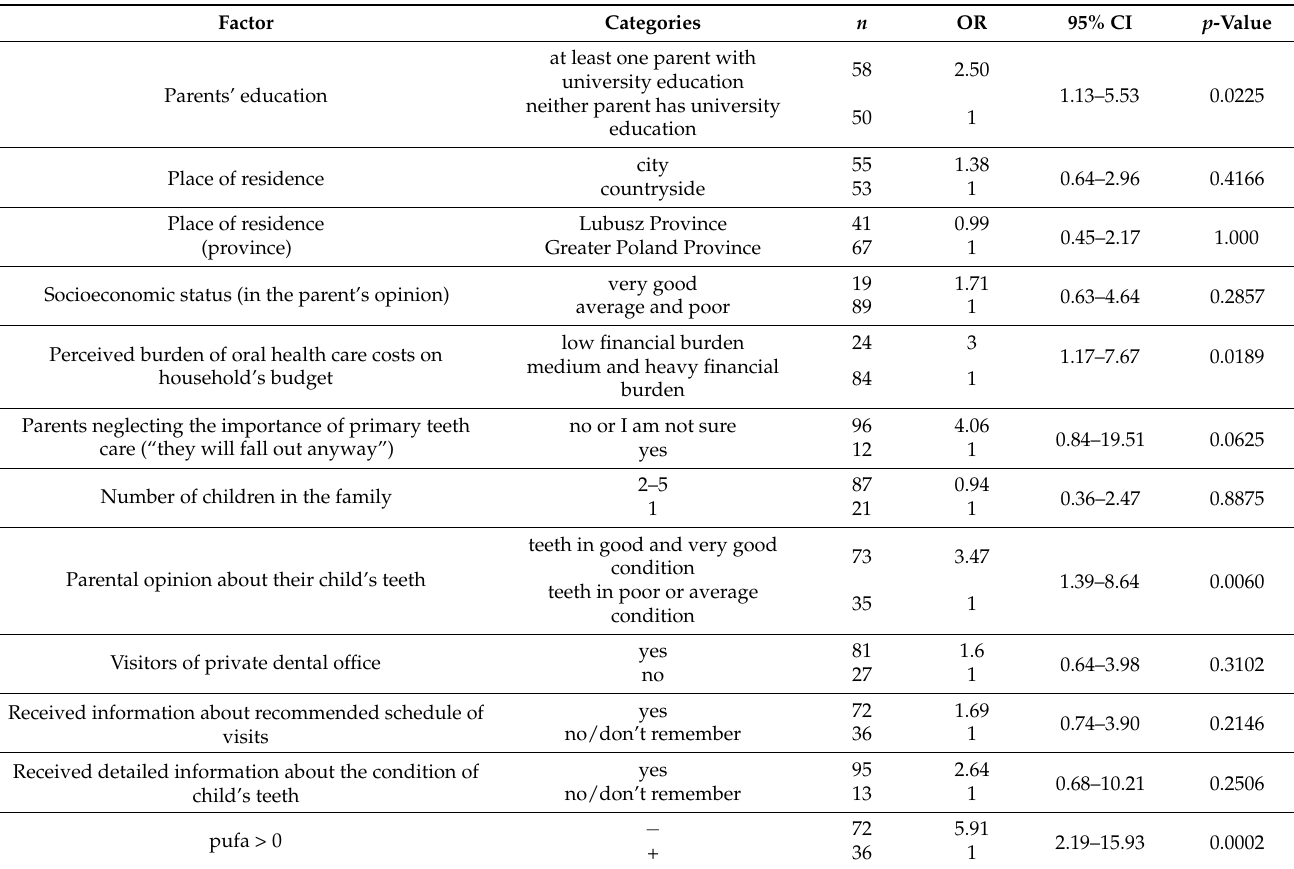
Table 7. Odds ratios for desirable oral health-related behavior (yearly dental check-ups despite lack of pain) according to various factors. Only subjects with a dental visit in the past year were included in the analysis ( n =